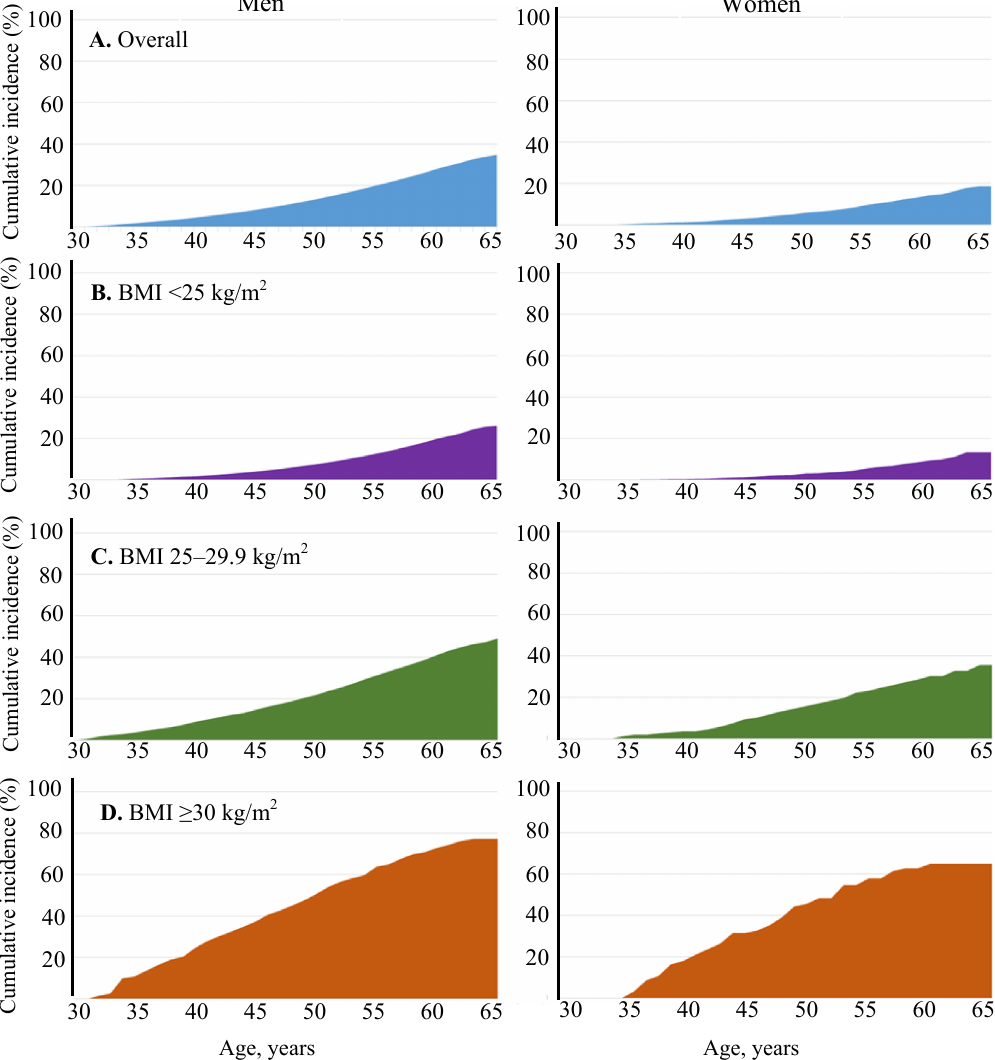
Figure 1. Cumulative risk of diabetes in individuals aged 30 years. A. Overall; B. BMI < 25kg / m 2 ; C. BMI 25 – 29.9kg / m 2 ; D. BMI ; 30kg / m 2